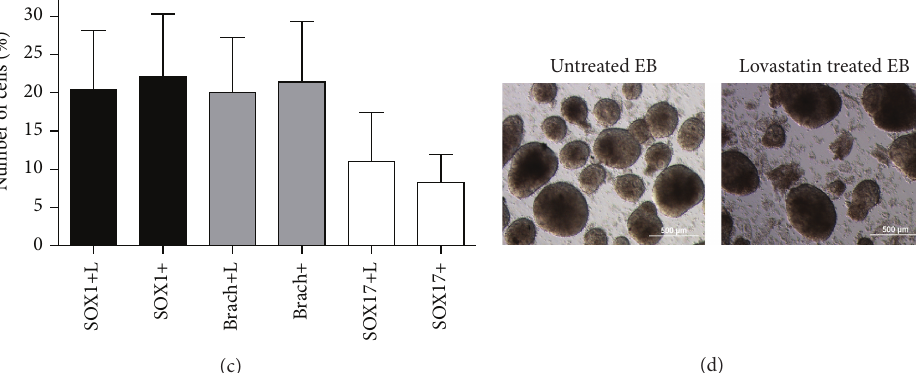
Figure 2: Expression of differentiation markers before and after formation of embryoid bodies from lovastatin treated or untreated cells. (a) Expression of the differentiation markers SOX1, OTX2 (ectodermal lineage), brachyury, HAND1 (mesodermal lineage), and SOX17 (endodermal lineage), and the pluripotency marker OCT4 in hES cells as detected by flow cytometric assay. Embryoid bodies were formed from untreated or 20 𝜇 M lovastatin treated hES cells and single cell suspension was used to ascertain the expression of the differentiation markers. (b) Expression of differentiation markers for untreated and lovastatin (L) treated hES cells and (c) of formed embryoid bodies. Results are shown as mean ± SEM ( 𝑛 = 4 ). (d) Morphology of formed EB (on day 5) from untreated and lovastatin treated hES